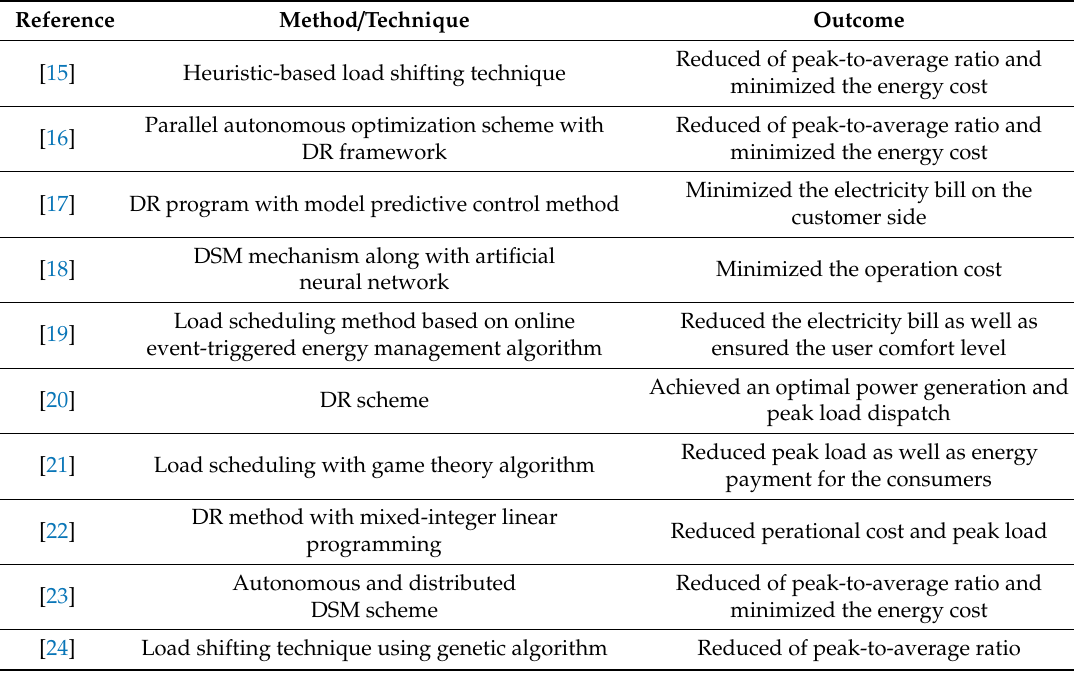
Table 1. Summary of some results of algorithms used in